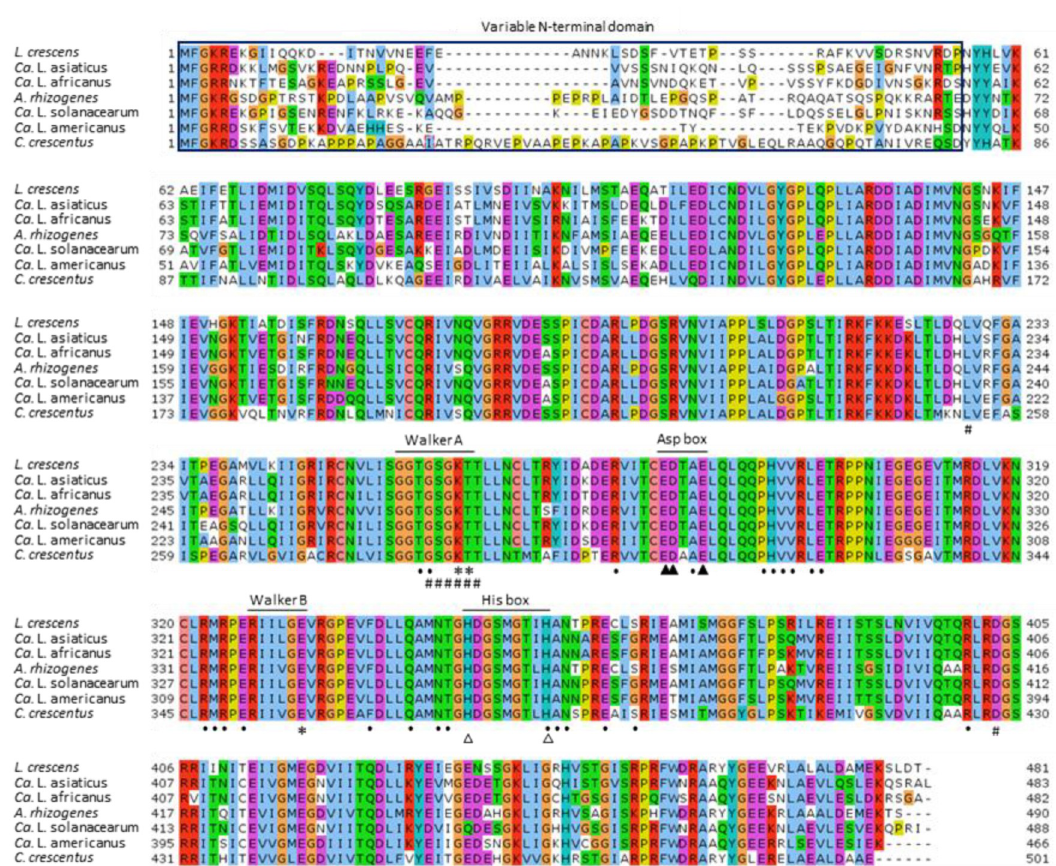
Fig 3. Tad pilus motor ATPase CpaF is structurally conserved among all Liberibacters. Sequence alignment of CpaF encoded by L . crescens BT-1 (WP_015273698.1), ‘ Ca . L. asiaticus’ (WP_015452438.1), ‘ Ca . L. africanus’ (WP_047264073.1), A . rhizogenes (WP_065114603.1), ‘ Ca . L. solanacearum’ (WP_076969128.1), ‘ Ca . L. americanus’ (AHA27602.1) and C . crescentus (YP_002518410.1). Invariant residues required for coordination of Mg 2+ between β - and γ -phosphate moieties of ATP within the canonical ATP-binding Walker A and Walker B motifs are marked by an asterisk ( � ). Invariant residues in Asp box and His box motifs are denoted by filled ( ▲ ) and open ( 4 ) triangles, respectively. Amino acids participating in ATP binding and ATPase activity are denoted by hashtags (#) and those involved in hexamer interface for subunit interactions are denoted by dots ( � ).